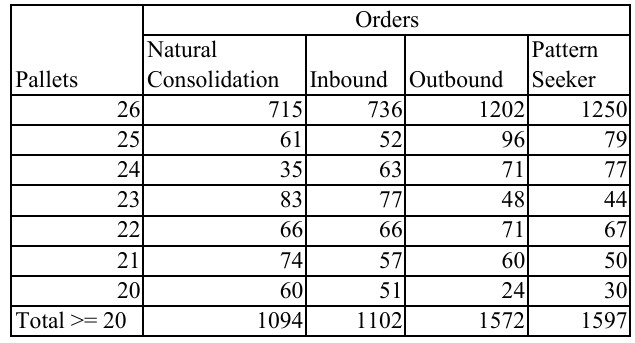
Figure 7. Results of cargo consolidations.